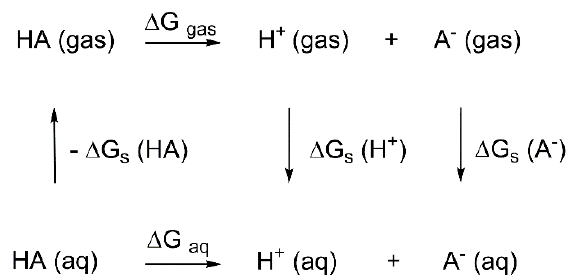
Figure 4. Thermodynamic cycle used for pK a calculation.